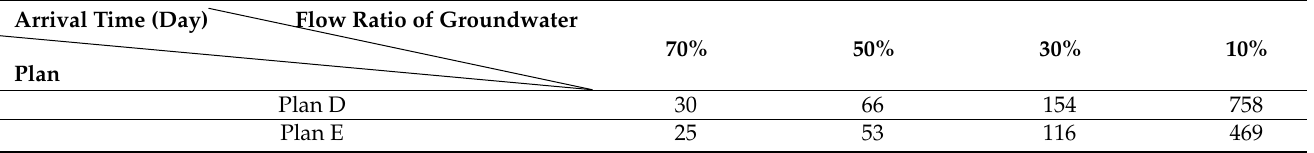
Table 3. Comparison of the day for plan D and plan E to reach the corresponding “flow ratio of